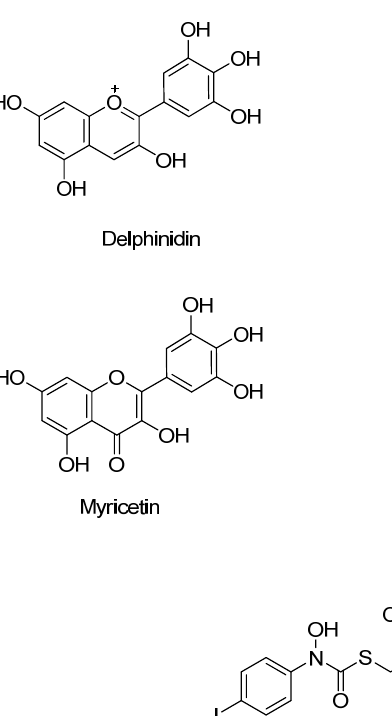
Figure 4. Structure of the five compounds reported as inhibitors of Glo-1